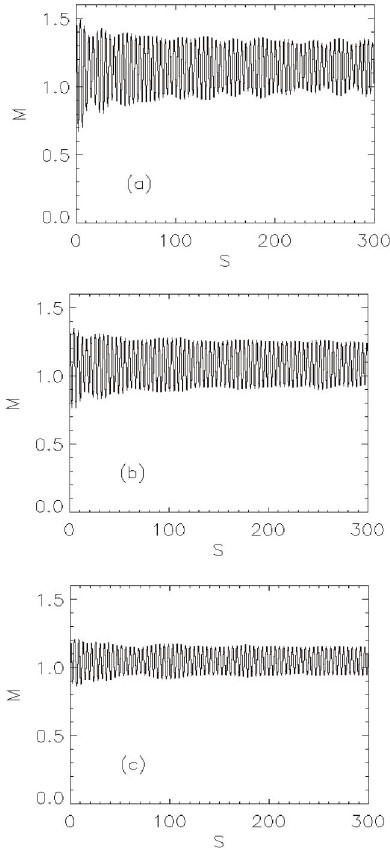
FIG. 3. Oscillation of the rms width of the beam for (cid:4) (cid:1) (cid:4) a (cid:5) 1.5, (b) 1.35, (c) 1.2.